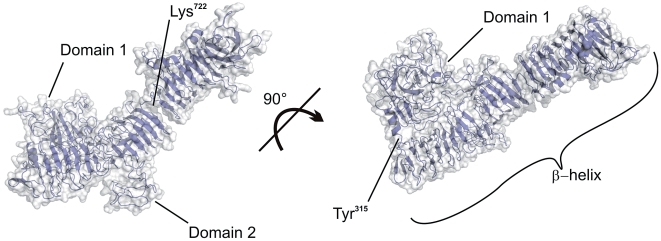
EspP homology model.Ribbon diagram (blue) with overlaid surface displaying the overall structure of the homology model of the EspP passenger. Domains 1 and 2 as well as the β-helical stem are indicated. Interface of Domain 1 and β-helix at position 315 and constriction within the helix at position 722 of the primary sequence of EspP are highlighted.